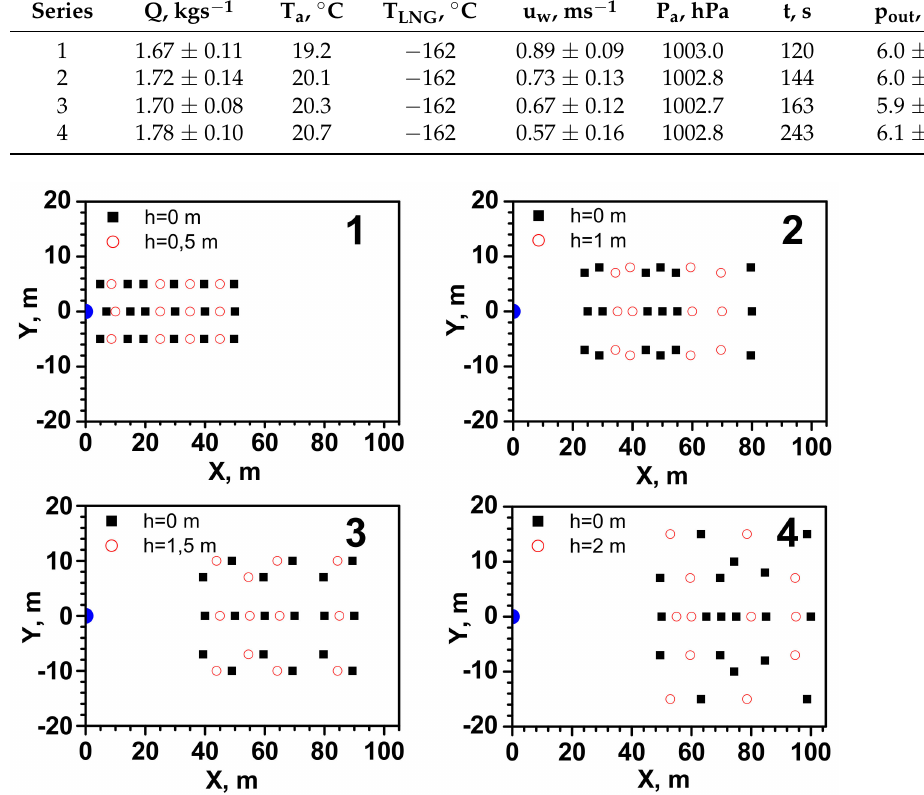
Figure 1. Schematic representation of the gas sensor placements, relative to the release location, during the 4 test runs. Permanent stations. Designations: h—height at which the sensor is installed; X, Y—location coordinates in relation to the site of